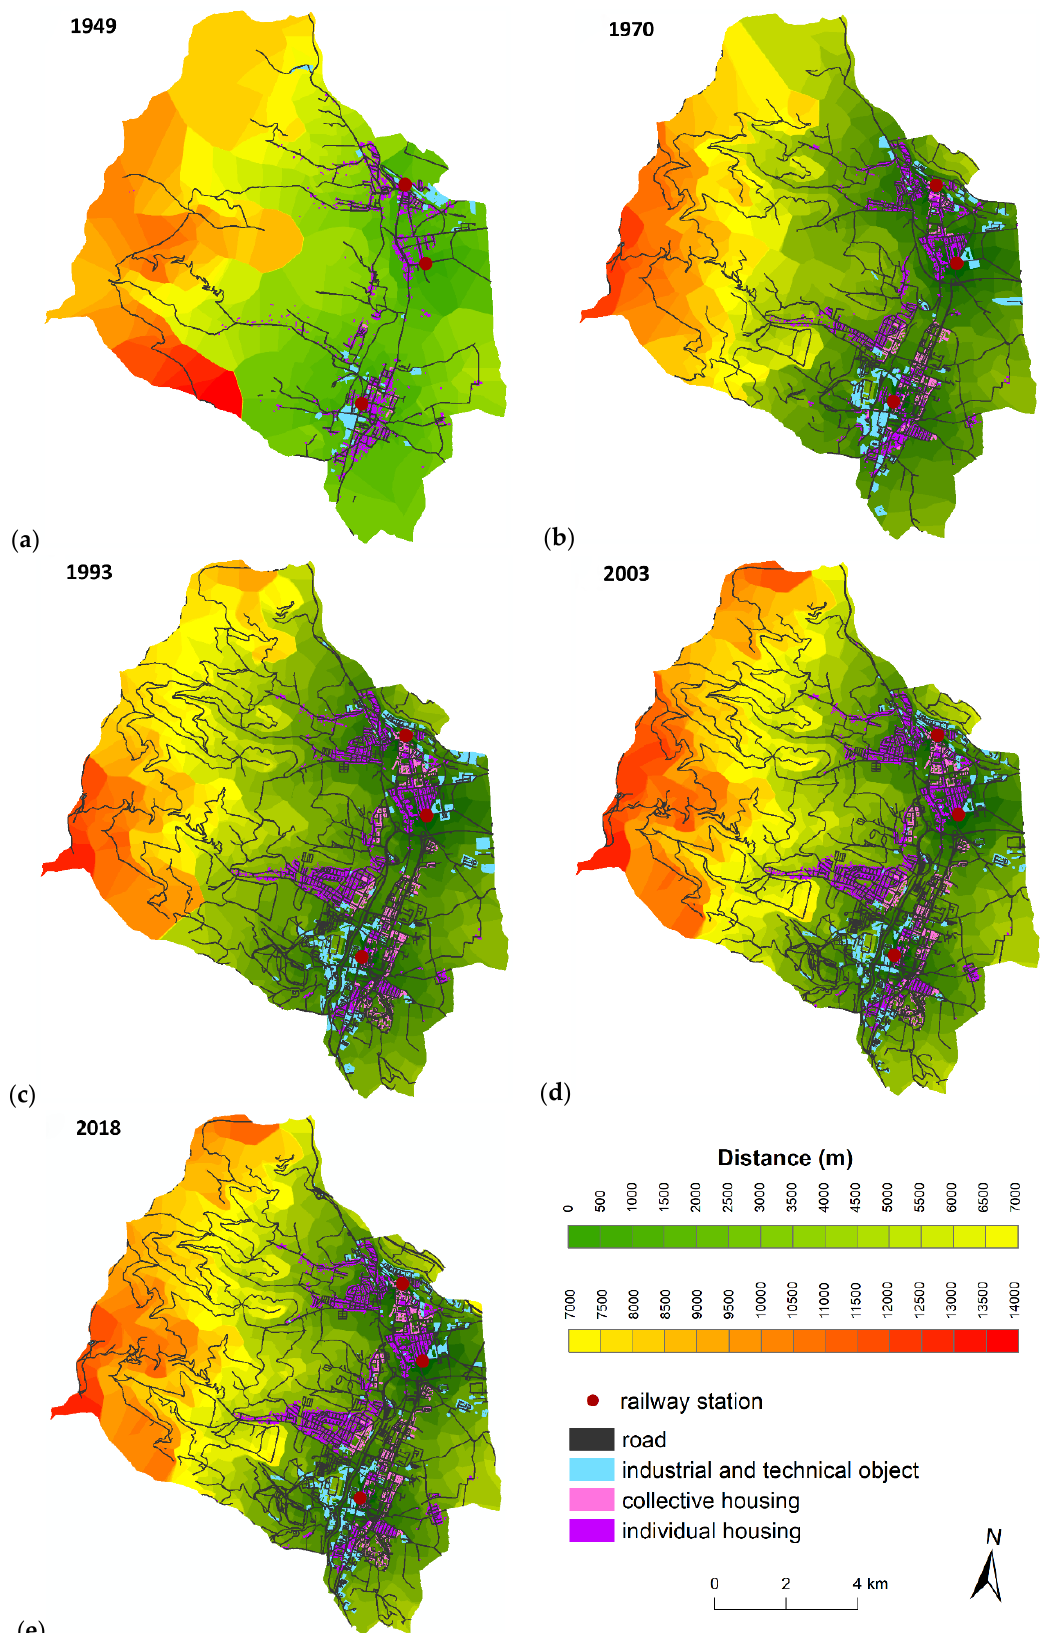
Figure 6. The accessibility of railroad stations and stops in 1949, 1970, 1993, 2003, and 2018 ( a–e ).